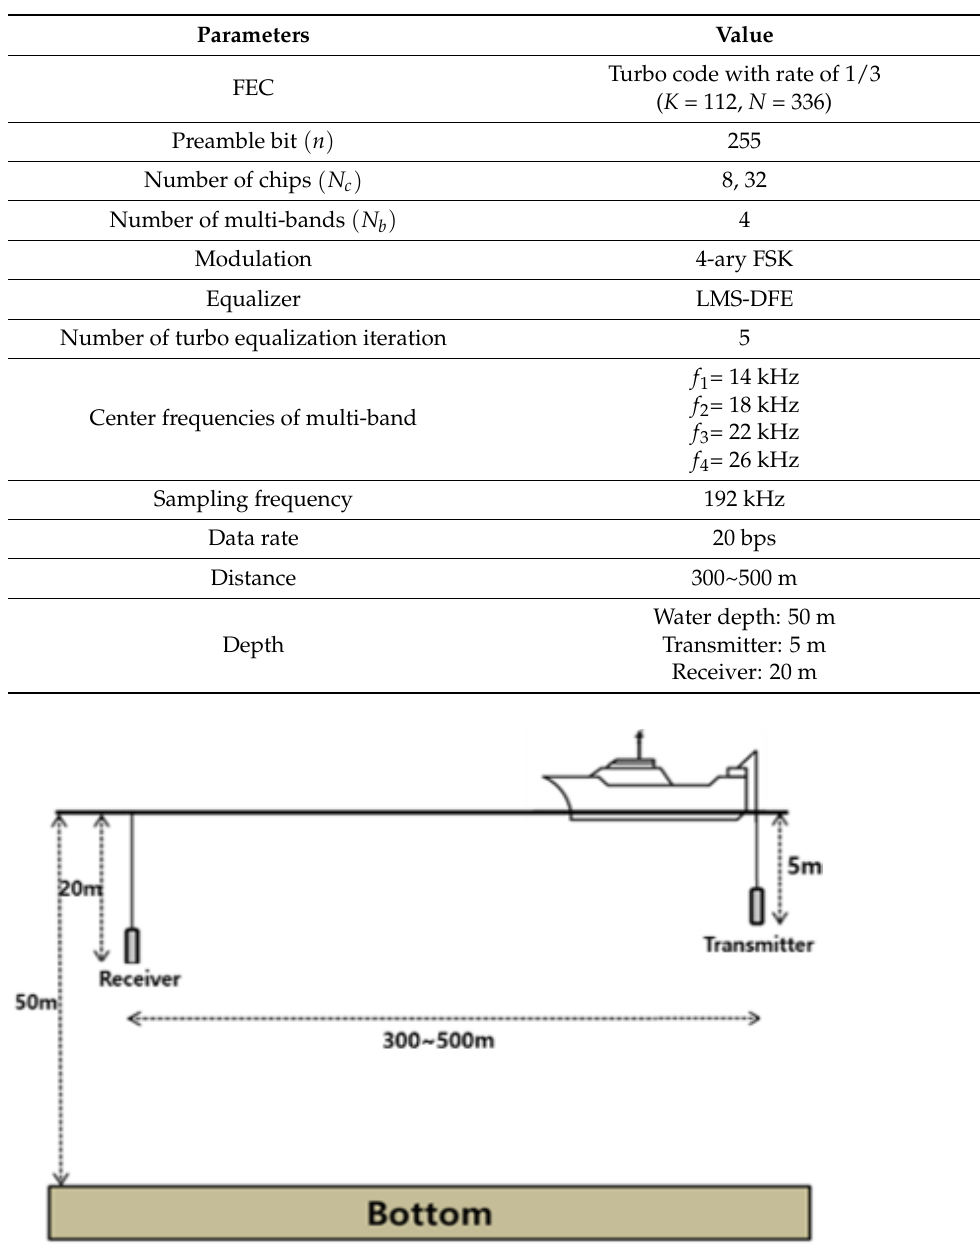
( b ) Figure 7. C hannel characteristic: ( a ) Channel impulse response and ( b ) Doppler spread.